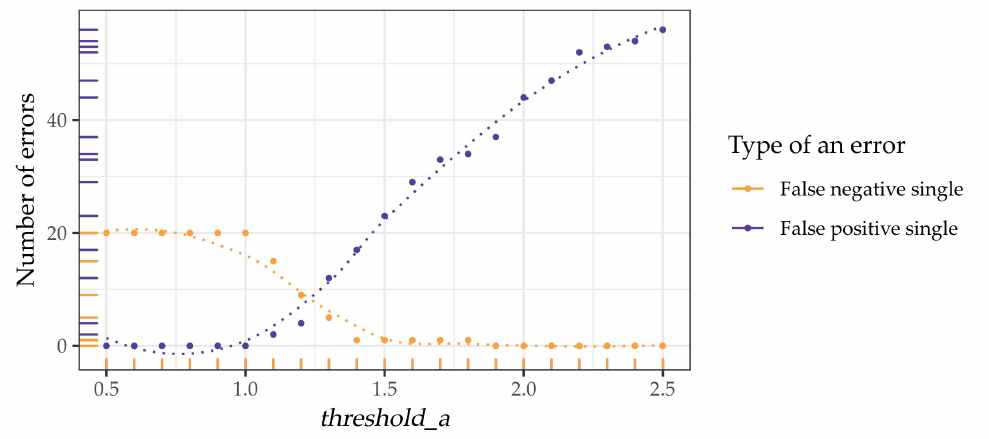
Figure 10. Results of pumpkin blob classification for different threshold_a values.